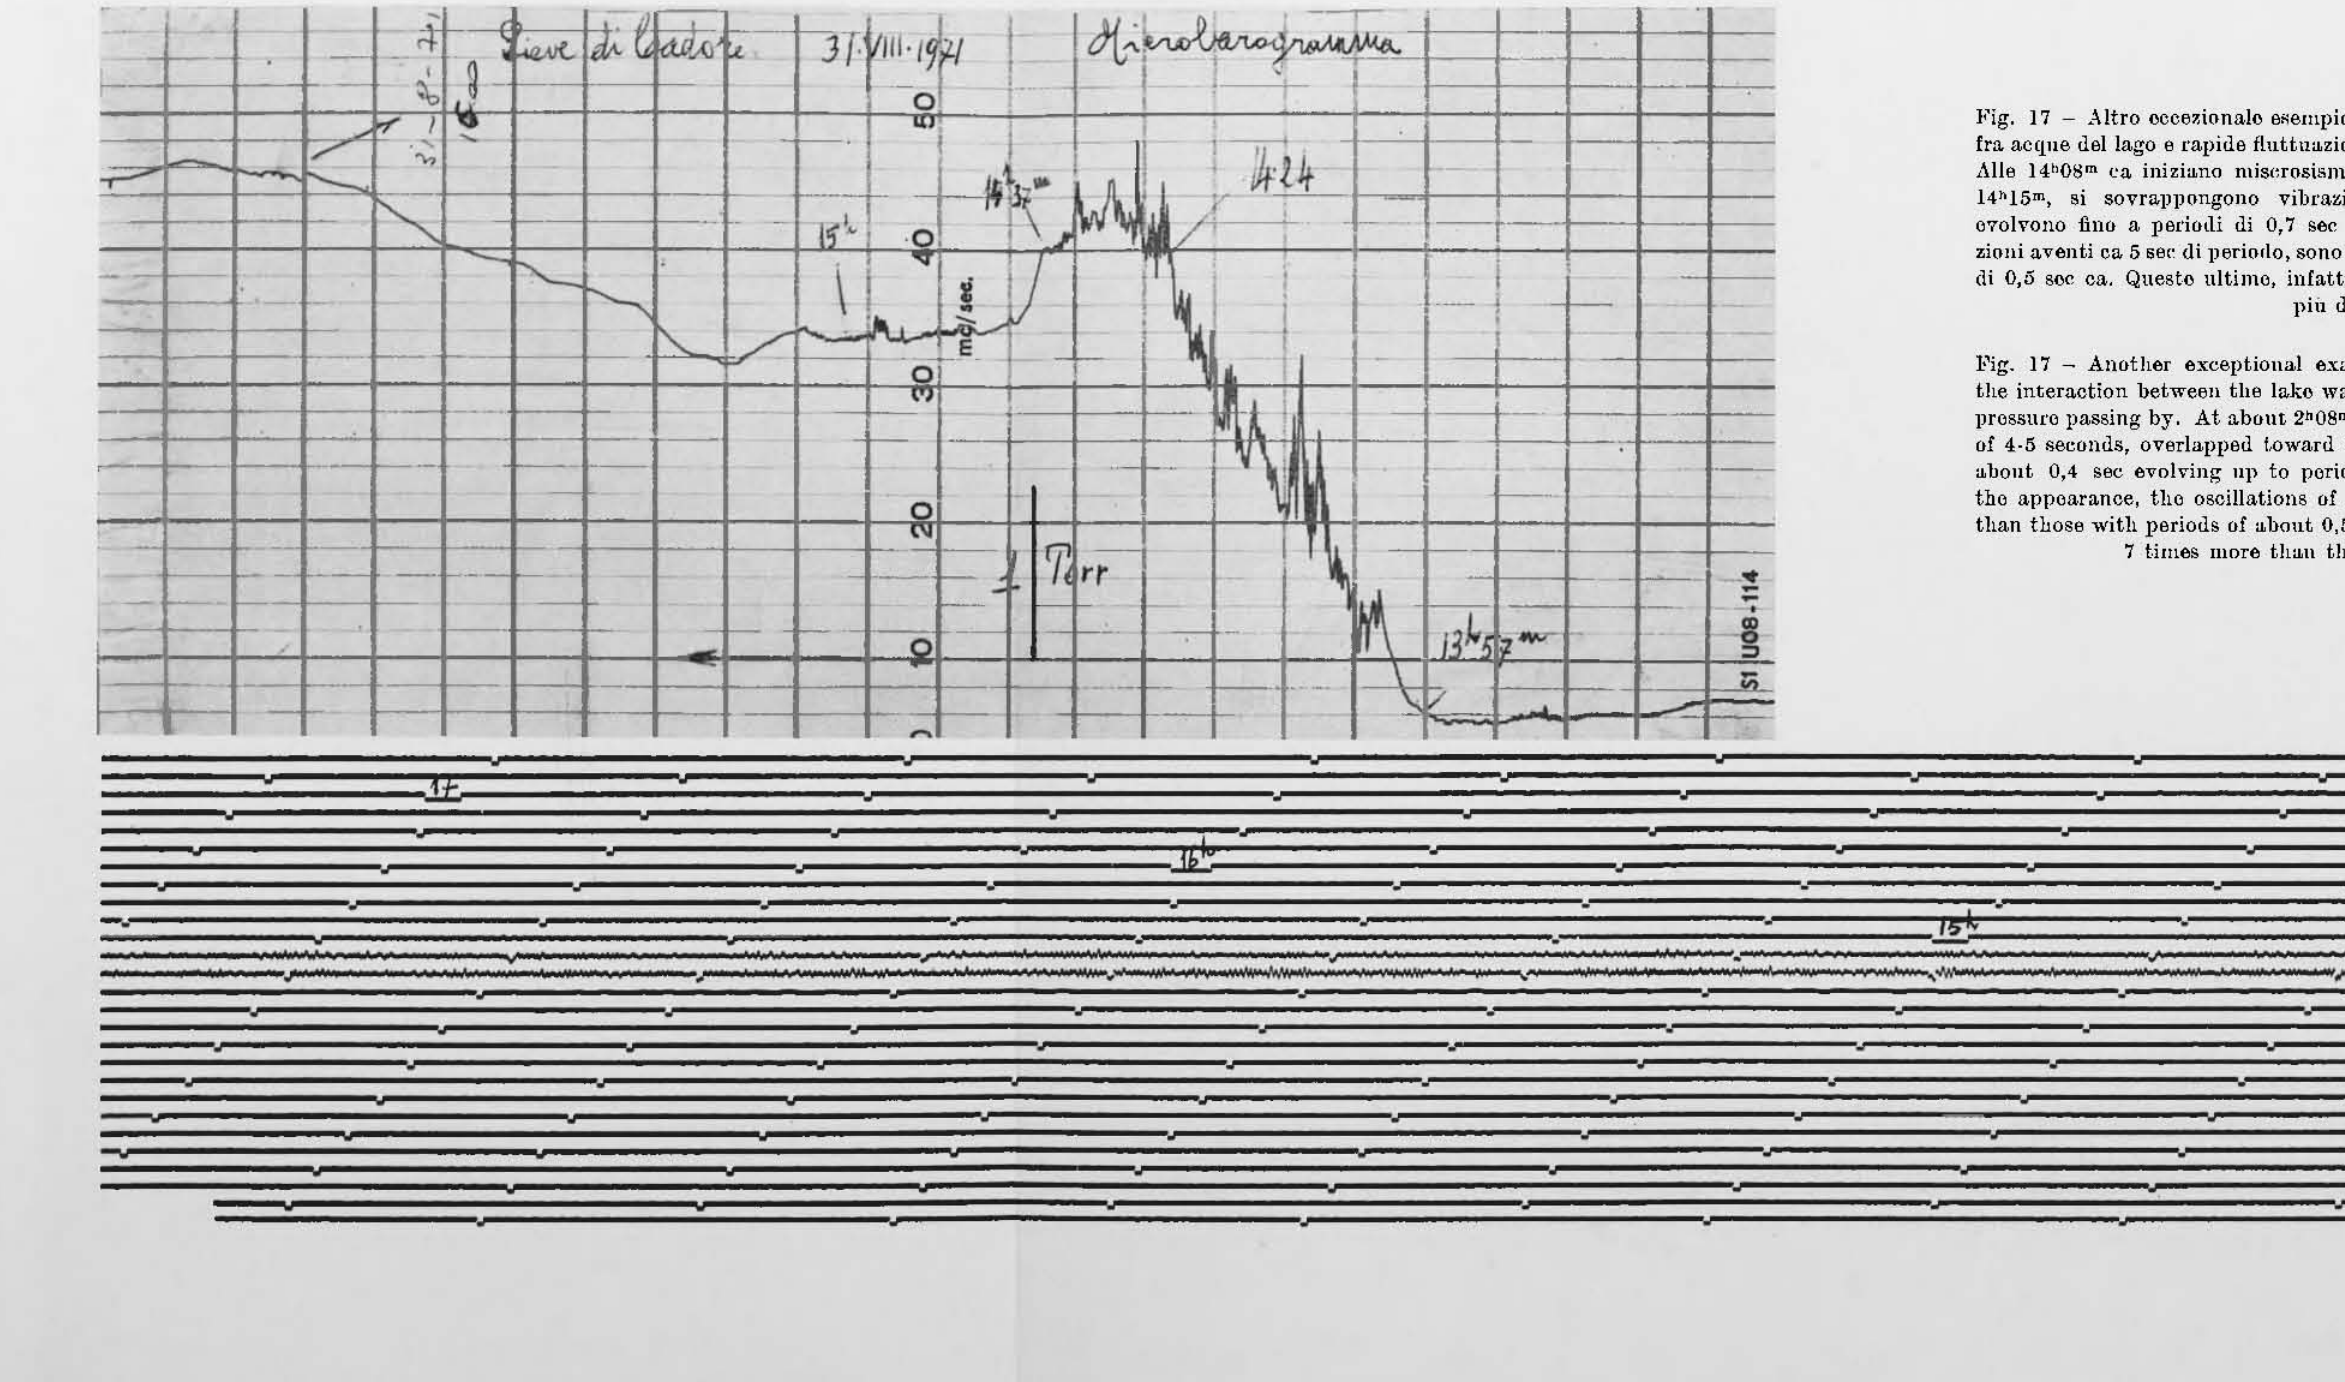
Fig. 17 - Altro ooco?ionalo e;;empio di microsismi, }Hovoeati tlall'intoraziono